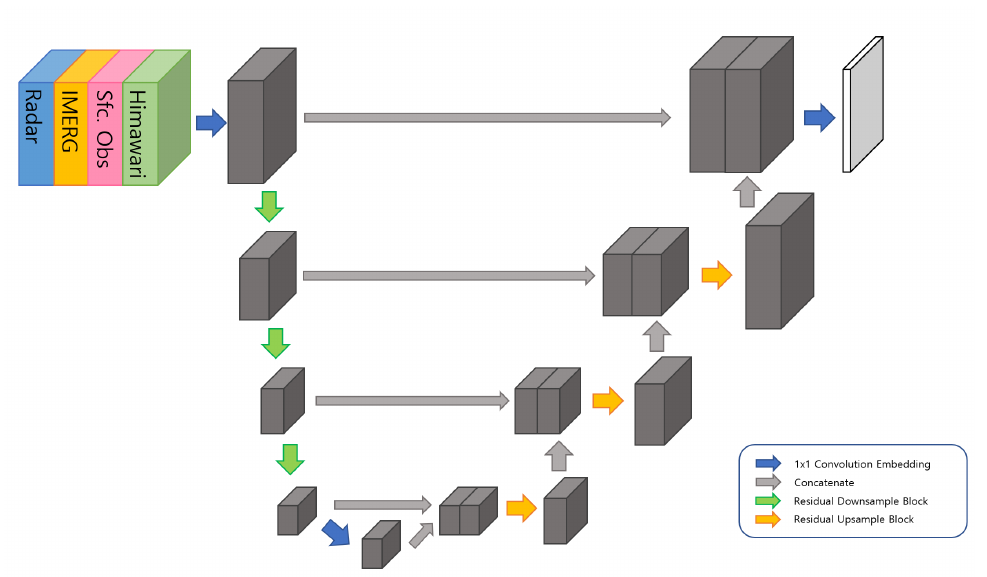
Figure 4. The RAIN-F+ benchmark model